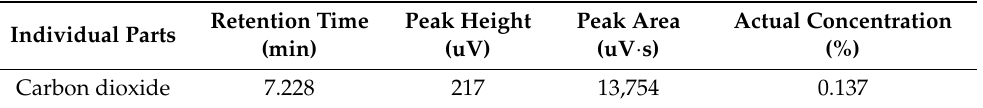
Figure 11. Chromatogram of thermal released carbon dioxide/nitrogen samples. Table 2. Results of gas chromatographic